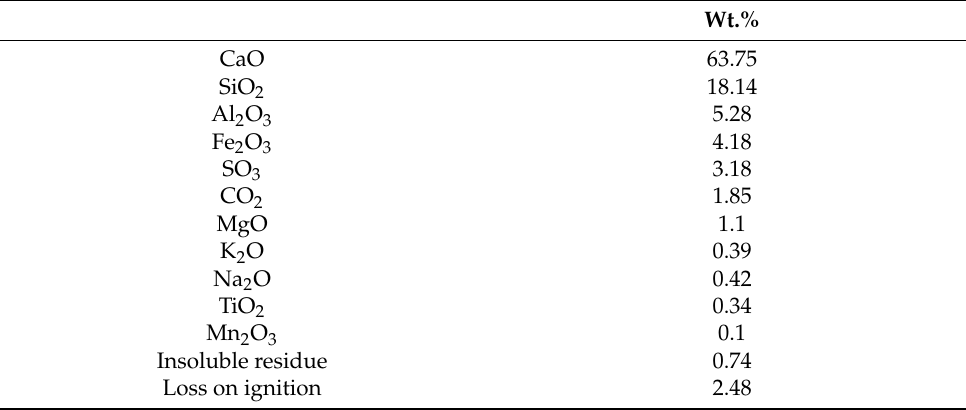
Table 1. Chemical composition of the used